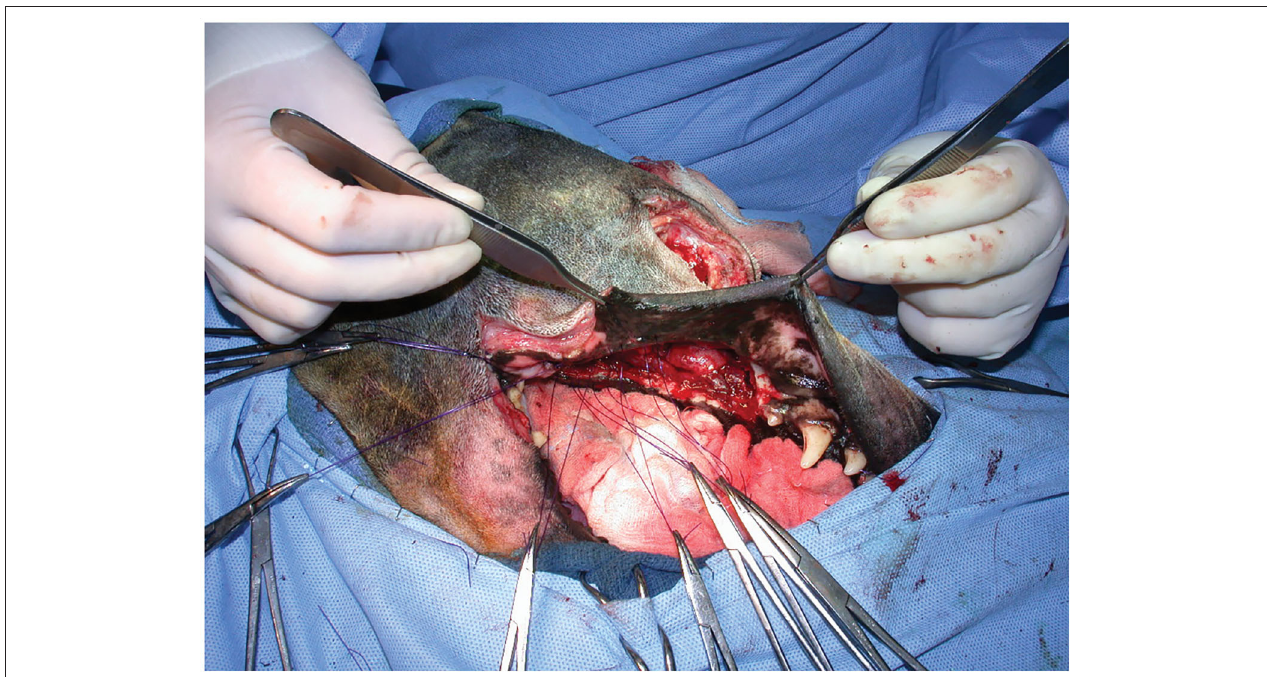
FIGURE 3 | Intraoperative photograph following arterial preligation and caudal maxillectomy via a combined approach. Note the lack of hemorrhage on the surgical drape.